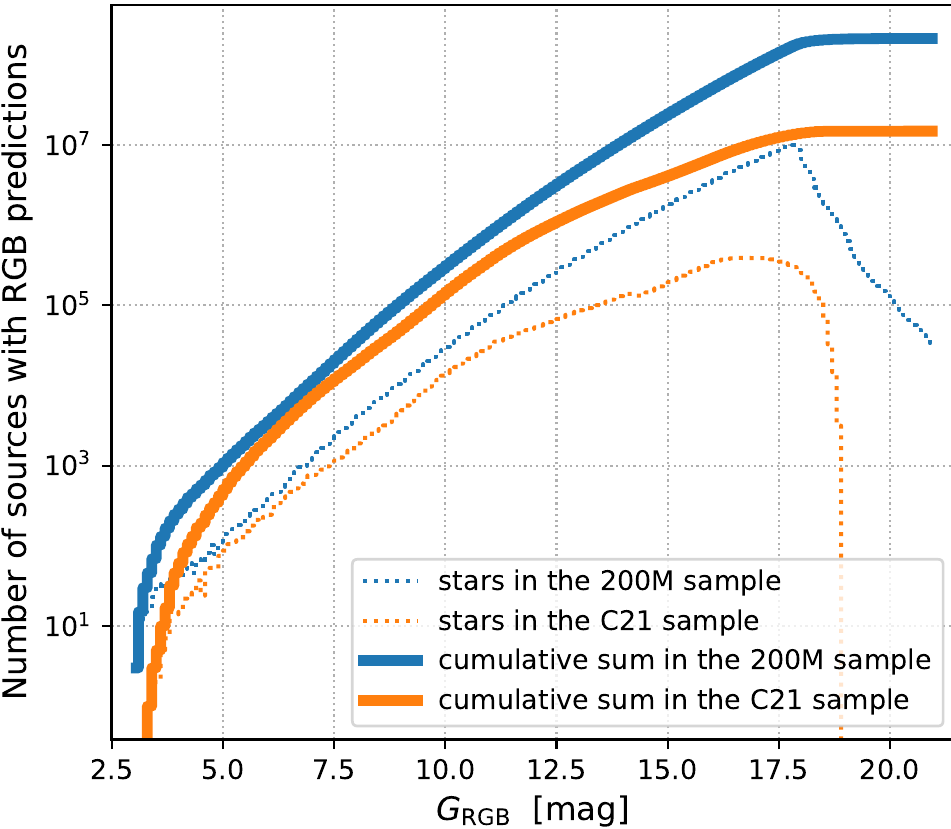
Figure 6. Variation in the number of sources with RGB magnitude predictions as a function of G RGB for both the 200 M (blue) and the C21 (orange) samples. The dotted lines show the histograms in bins of 0.1 mag, whereas the thick full lines display the cumulative